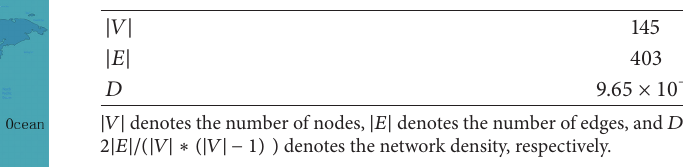
Table 1: Basic statistics of the observed ecological